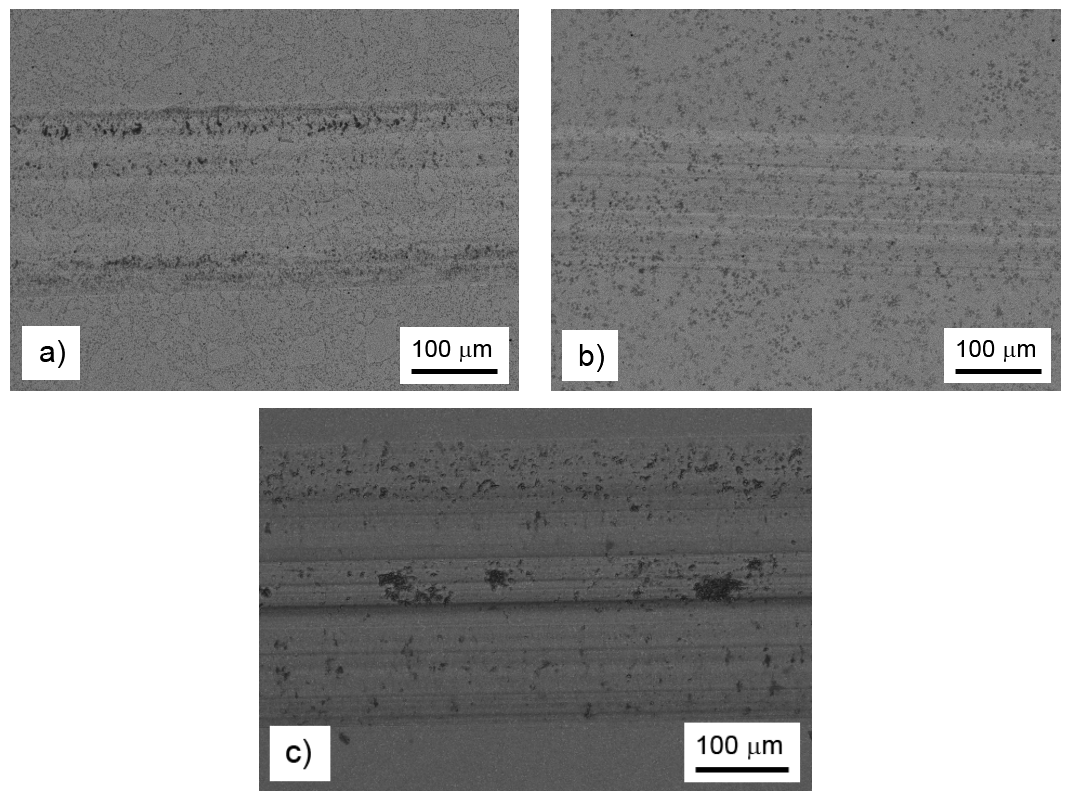
Figure 6. Wear tracks on the FeAl35Si5 alloy ( a ), the FeAl35Si5Ni20 alloy ( b ), and the FeAl35Si5Ti20 alloy ( c ), as documented by backscattered electrons (BSE)-SEM.